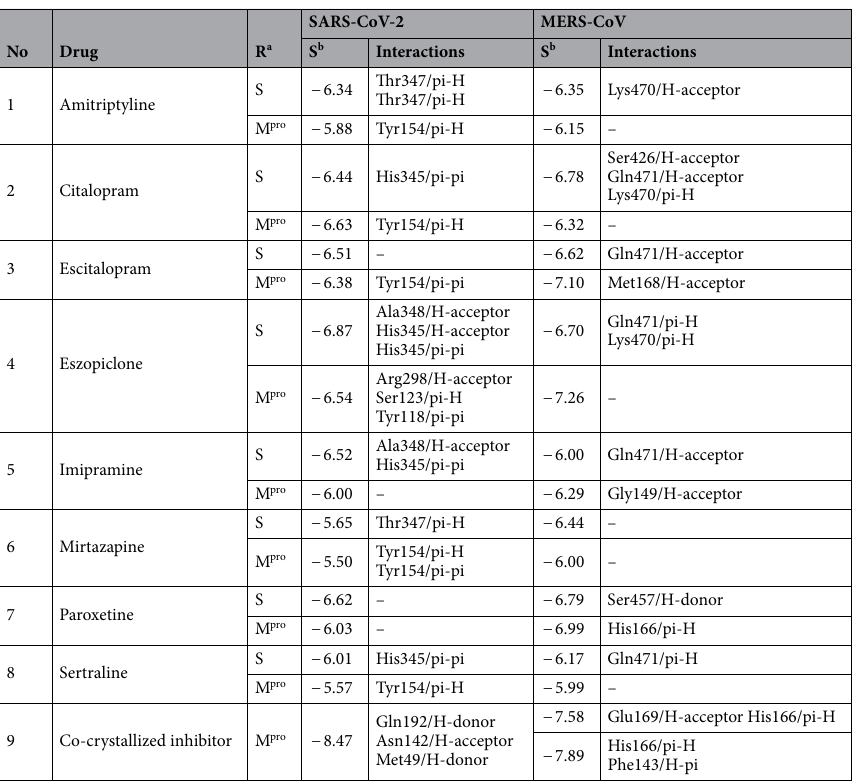
Table 1. The binding scores and interactions of the examined FDA-approved antidepressant drugs (1–8) and the docked co-crystallized inhibitors (9) of M pro pocket inside the S and M pro binding sites of both SARS- CoV-2 and MERS-CoV. S, the spike protein; M pro , the main protease receptor. a The receptor pocket. b The score of a ligand inside the binding pocket